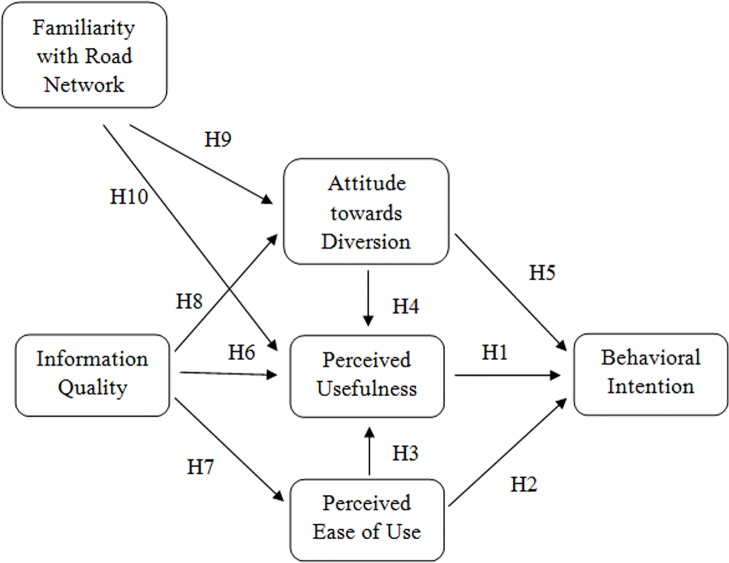
Study framework.